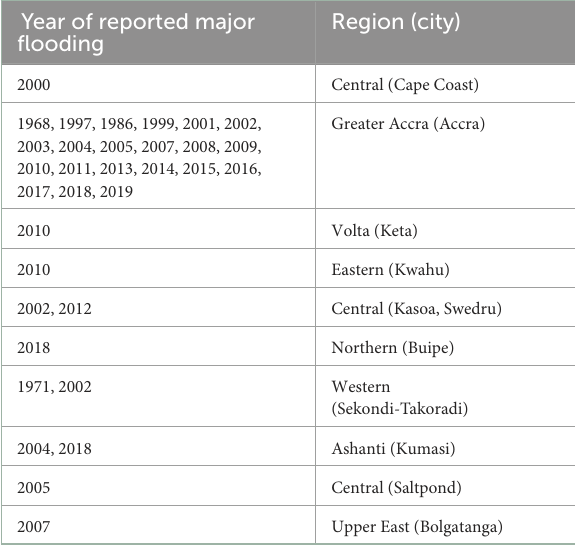
TABLE 3 Some major floods in Ghana (Mensah and Ahadzie,